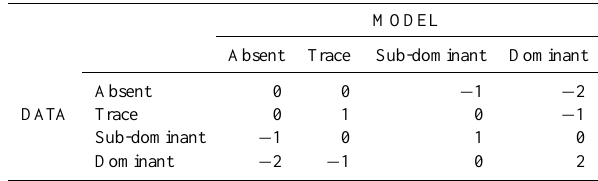
Table 1. Contributions to the agreement index for each combination of data and model